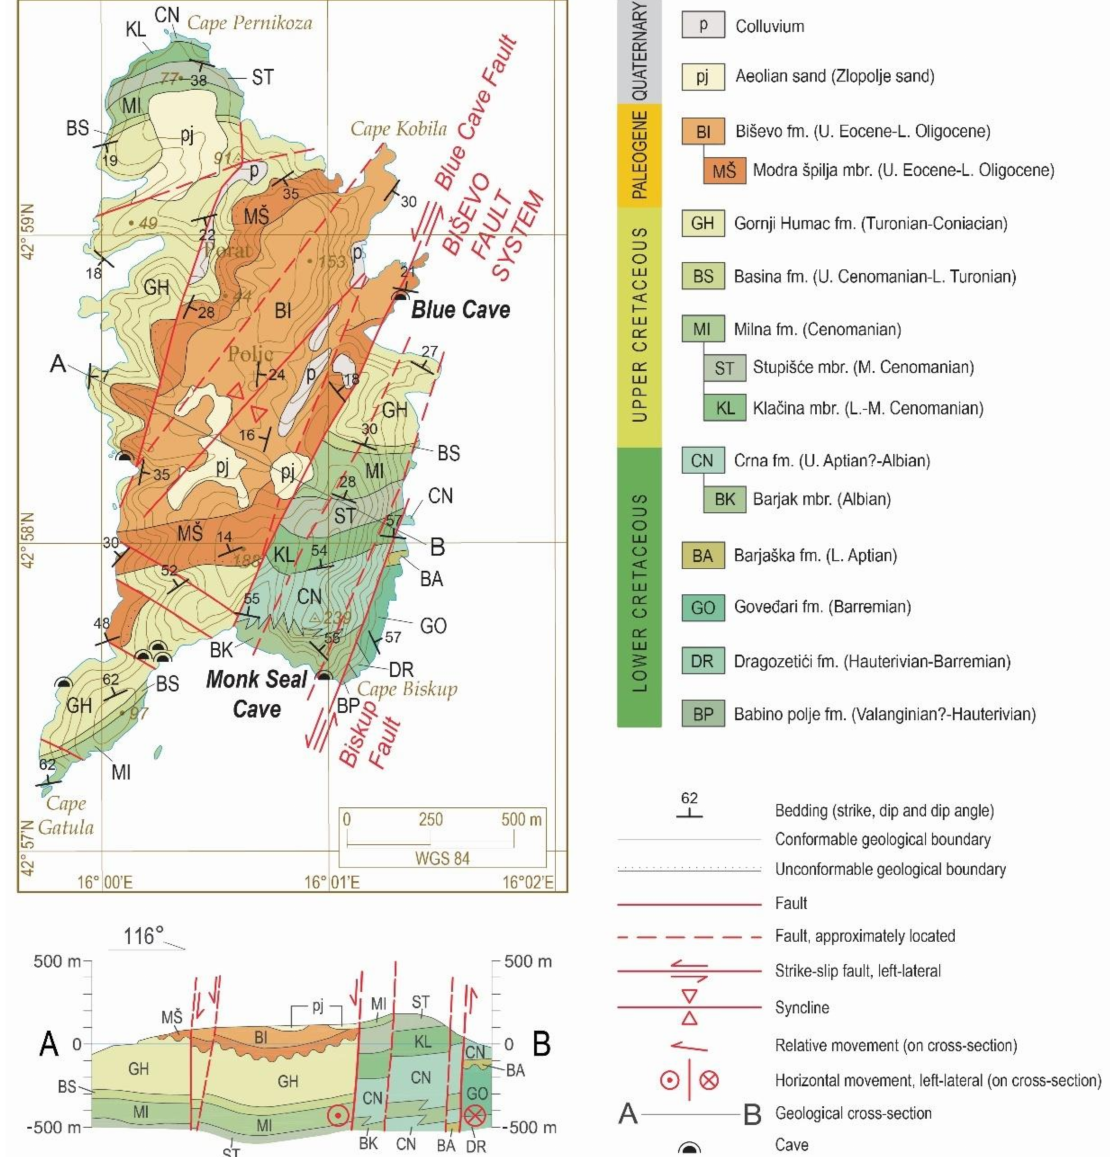
Figure 2. Geological map and the ( A , B ) cross-section (including legend) of Biševo Island [3], showing positions of all investigated speleological objects and the two most popular caves presented in this